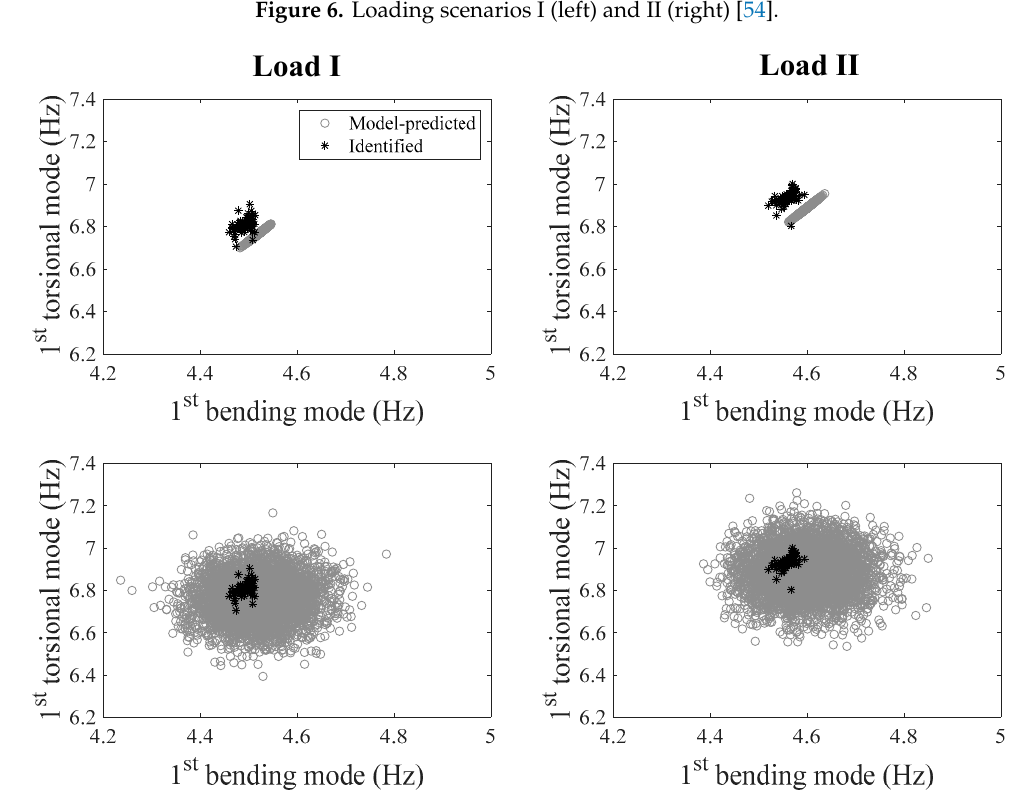
Figure 7. Comparison between model-predicted and identified natural frequencies in two loading scenarios (left column: loading scenario I; right column: loading scenario II), with/without accounting for error function (top row: without error function; bottom row: with error function).